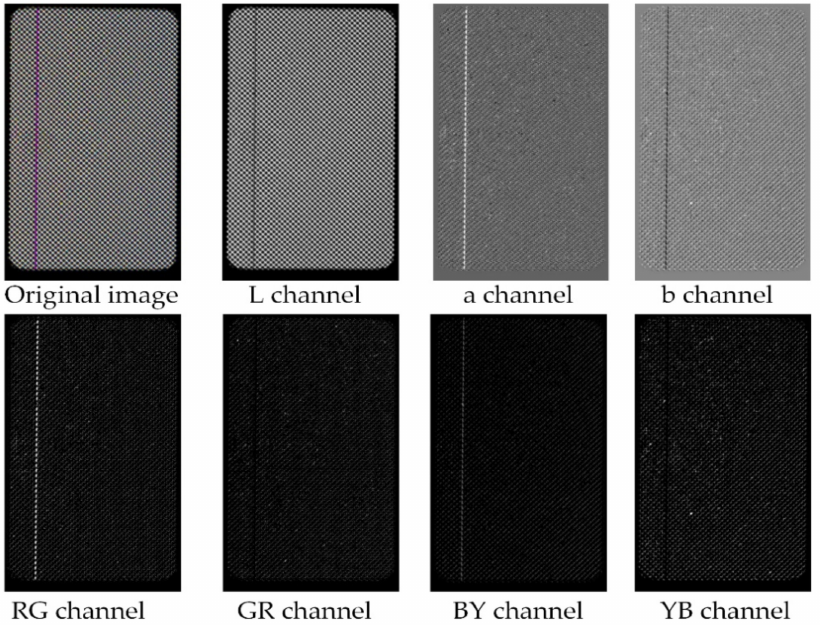
Figure 2. Decomposition of original image using Lab color space and RGBY color space. As shown in Figure 2, the Lab color space divides the original image into two parts. The brightness characteristics of the L channel are almost the same as the original image. The purple line defects of the image in the a channel are highlighted, while the background information is converted to a smaller value, and the position of the purple line in the b channel is converted to a value close to 0. In RG|GR-BY|YB space, the original image is mapped into four